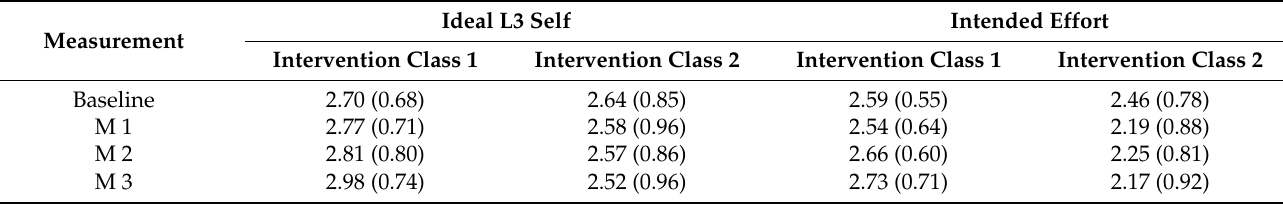
Table A4. Mean and SD for ideal L3 self and intended effort according to